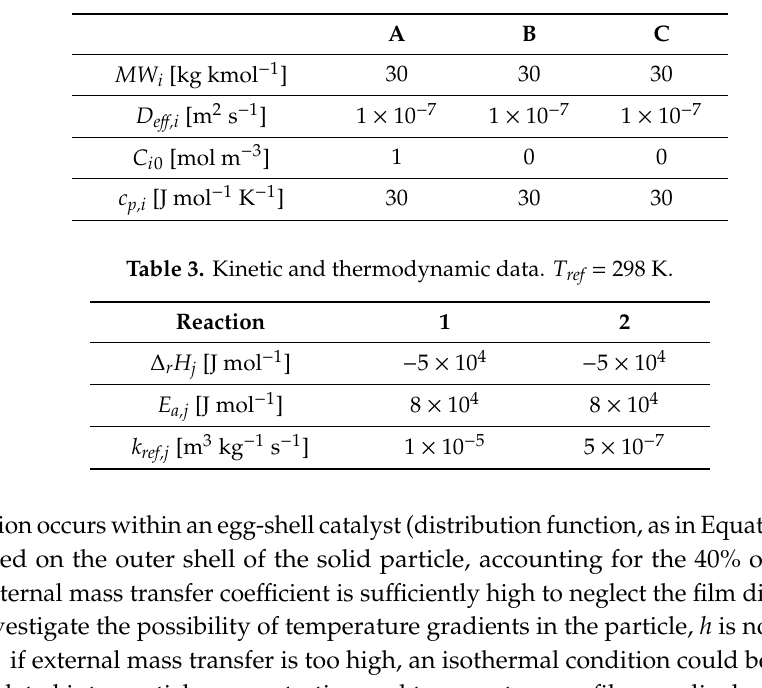
Table 2. Fluid component parameters.